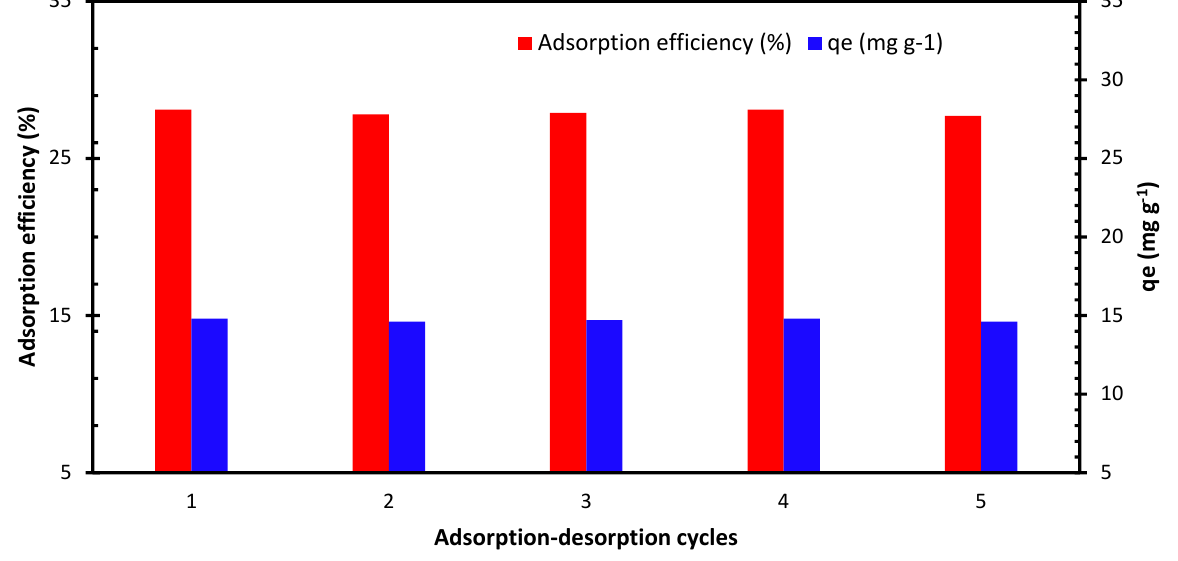
Figure 7. Stability test of heparin recovery over the QDASi.